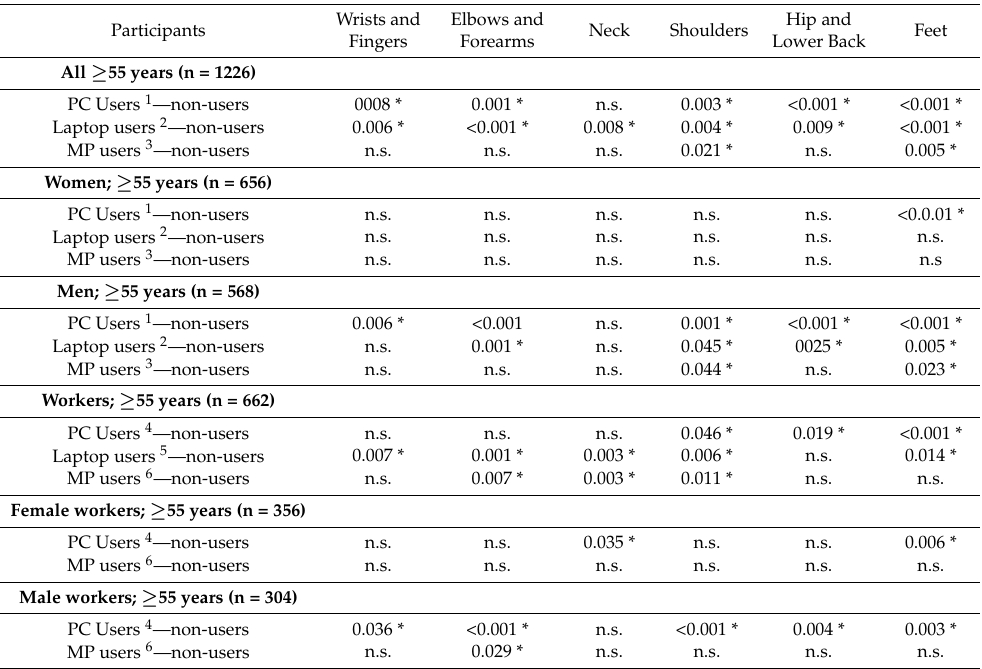
Table 3. The results of the ≥ 55-year-old persons using Mann-Whitney U-Test for Question 13. The comparisons are the following: (1) persons who used a desktop computer daily at leisure and non-users, (2) daily users of laptops and non-users, (3) daily users of a mobile phone and non-users. This table also includes the same comparisons for women and men and workers, and comparisons 1 and 3 for female workers and male